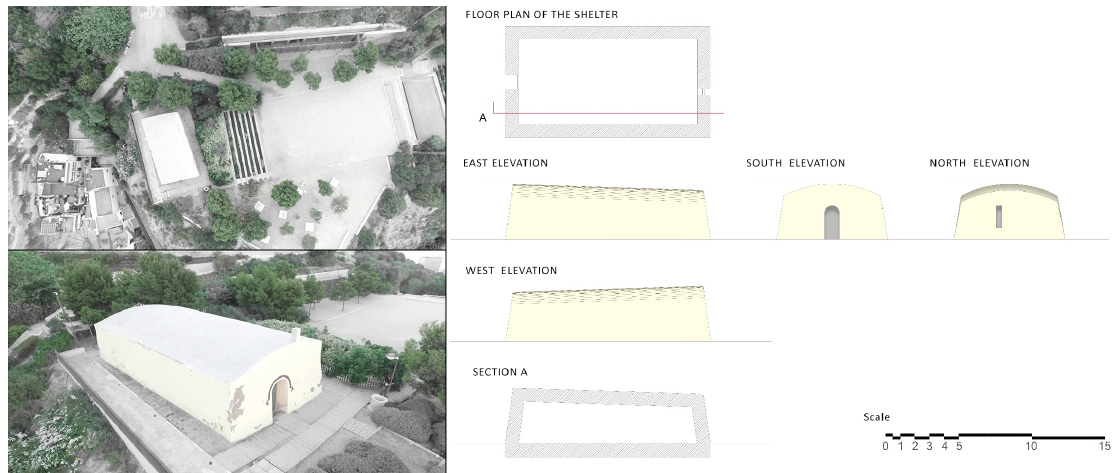
Figure 6. Image of the Ereta powder magazine made with a drone at a height of 20 m above ground